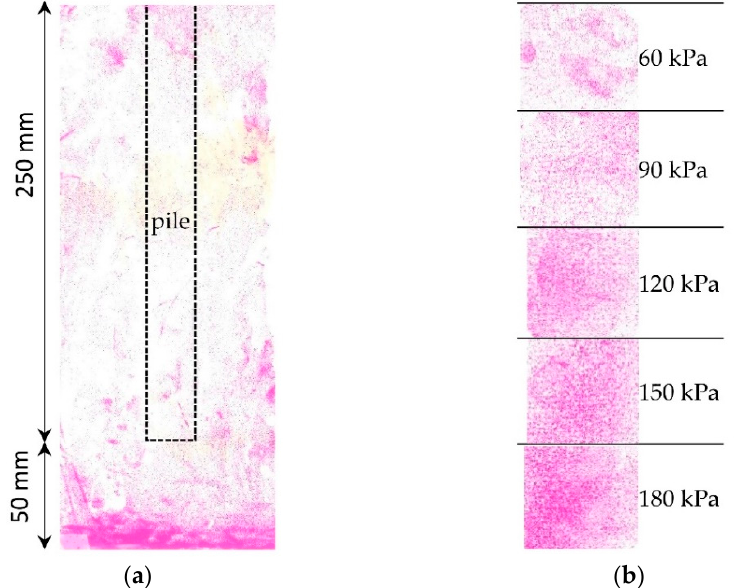
Figure 20. Pressure in the soil obtained from the test P5.R.CFS: ( a ) pressure map of horizontal stresses; ( b ) pressure scale.